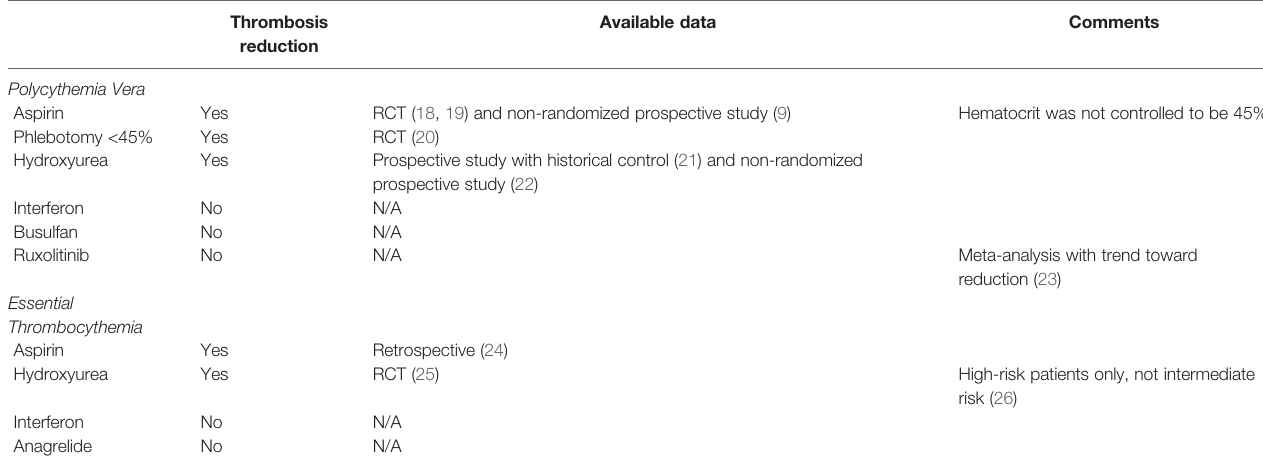
TABLE 2 | Summary of available evidence for available therapies for reduction of thrombotic